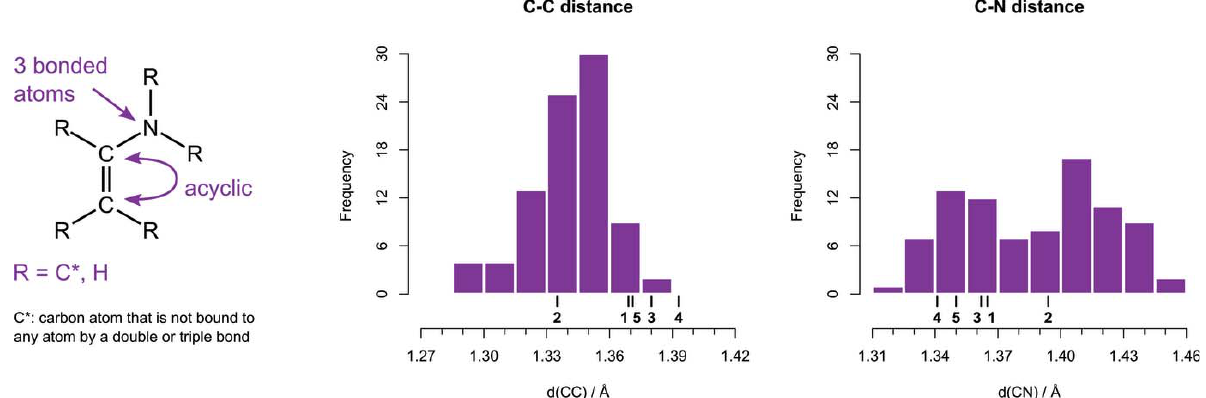
Figure 4 Statistical analysis of C—C and C—N bond lengths in enamines. The query substructure and restrictions are shown on the left. Problematic or irrelevant structures were removed. The bond distances of reference compounds are marked.